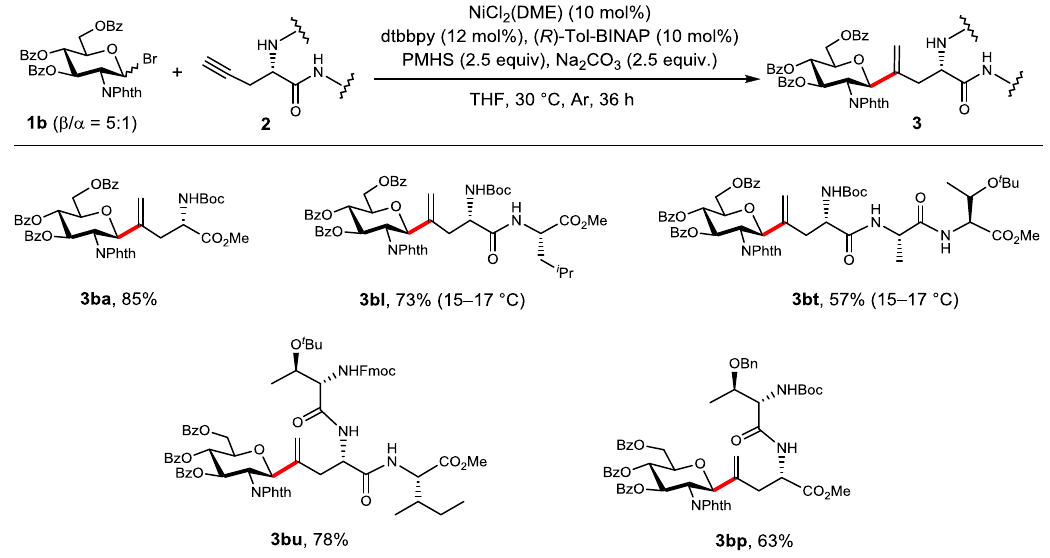
Fig. 4 Scope of C -glycosylation with glucosamine donor 1b. 1b (0.1 mmol), 2 (2.0 equiv.), NiCl 2 (DME) (10 mol%), dtbbpy (12 mol%), ( R )-Tol-BINAP (10 mol%), PMHS (2.5 equiv.), Na 2 CO 3 (2.5 equiv.), THF (1 mL), 30 °C or as noted, Ar, 36 h. Isolated yields are reported. In red are the formed C -glycosidic